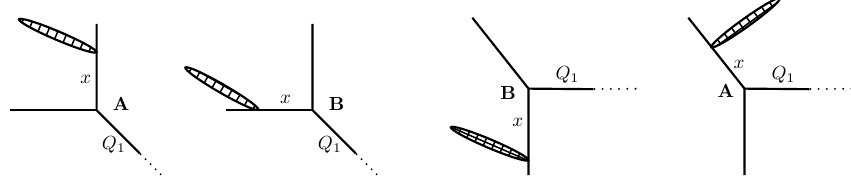
Figure 2: If a brane is attached to the first vertex, the type of this vertex depends on